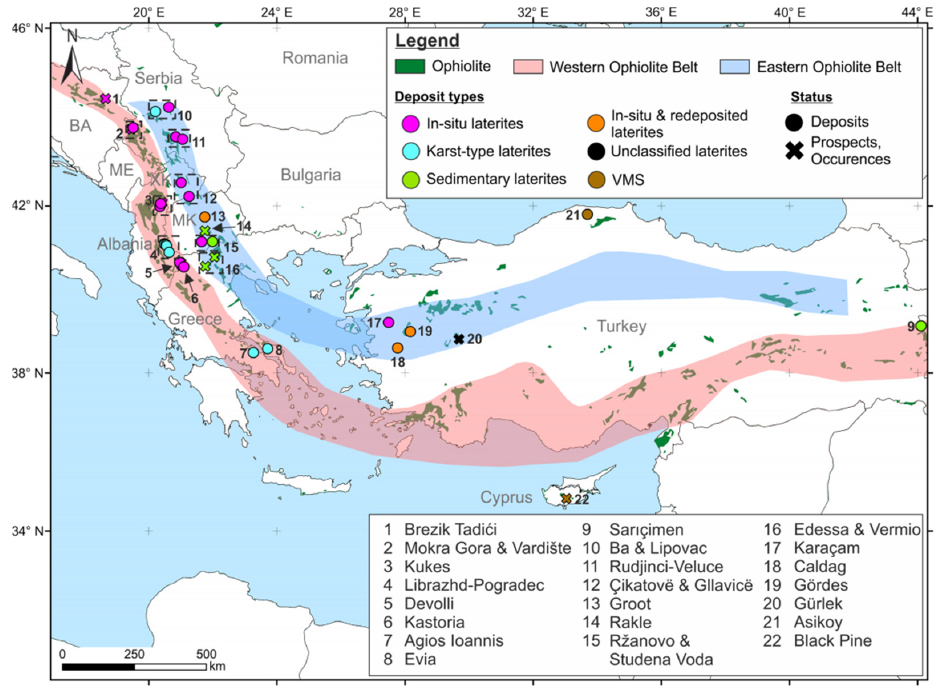
Figure 4. Laterite deposits in the Eastern and Western Ophiolitic Belt. The figure is reproduced from [6]. Laterites originating from the Balkan Peninsula and tropical areas differ